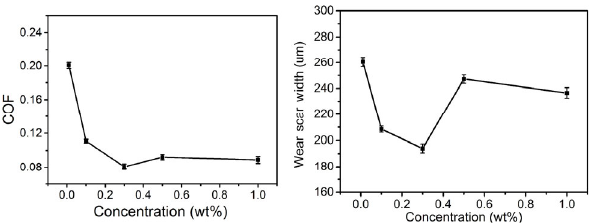
Fig. 4 Variations of COFs and wear scar width with increasing concentrations for TRGO lubricant for the steel/copper friction